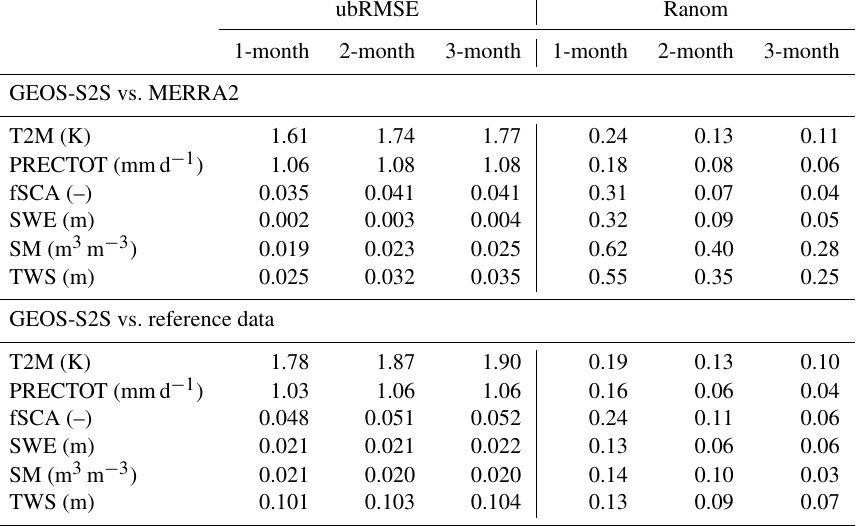
Table 2. The unbiased RMSE (ubRMSE) and the anomaly correlation (Ranom) for all variables when comparing the GEOS-S2S forecasts to the reanalysis (“MERRA-2”) and the reference data products (“reference data”). The reference data that are used here are as follows: ERA5 for T2M, APHRODITE for PRECTOT, MODIS for fSCA, HMA-SR for SWE, ESA-CCI for SM, and GRACE for TWS (Sect. 2.3). ubRMSE